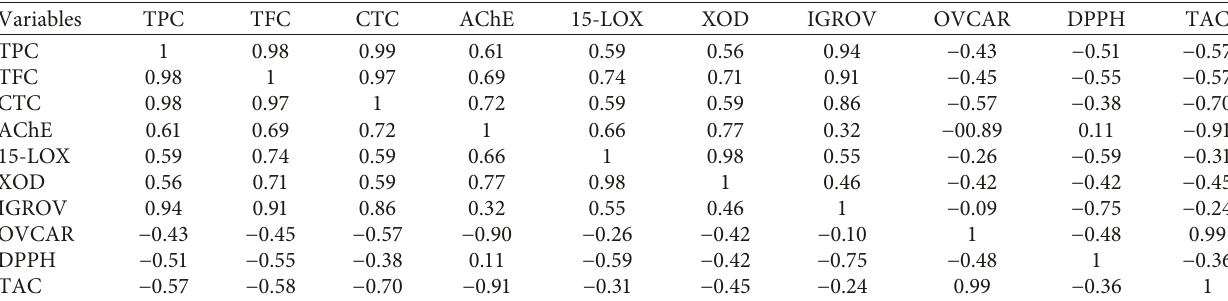
Table 5: Correlation matrix (Pearson (n)).